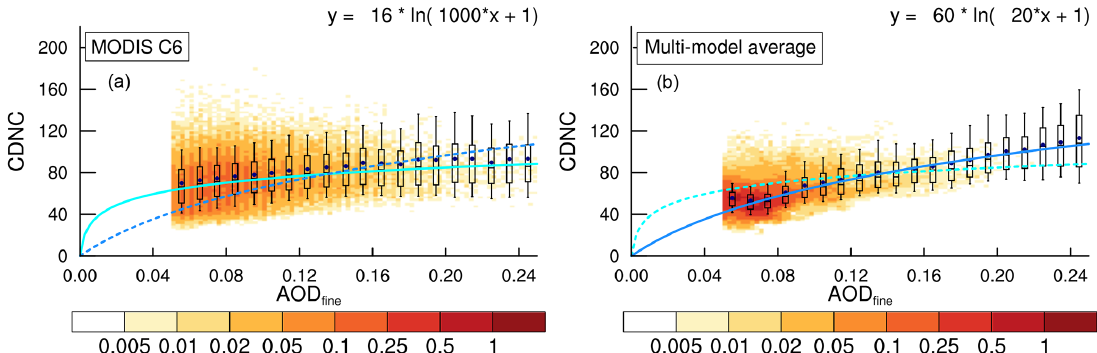
Figure A3. AODf vs. CDNC relationships as in Fig. A2 but here based on a satellite retrieval ( a , here MODIS 6) and on the AeroCom model ensemble average (b) . Note the much steeper slope in global modeling (dark blue lines) which indicates a much stronger Twomey effect by global modeling than by satellite-retrieval-based observations (light blue lines).